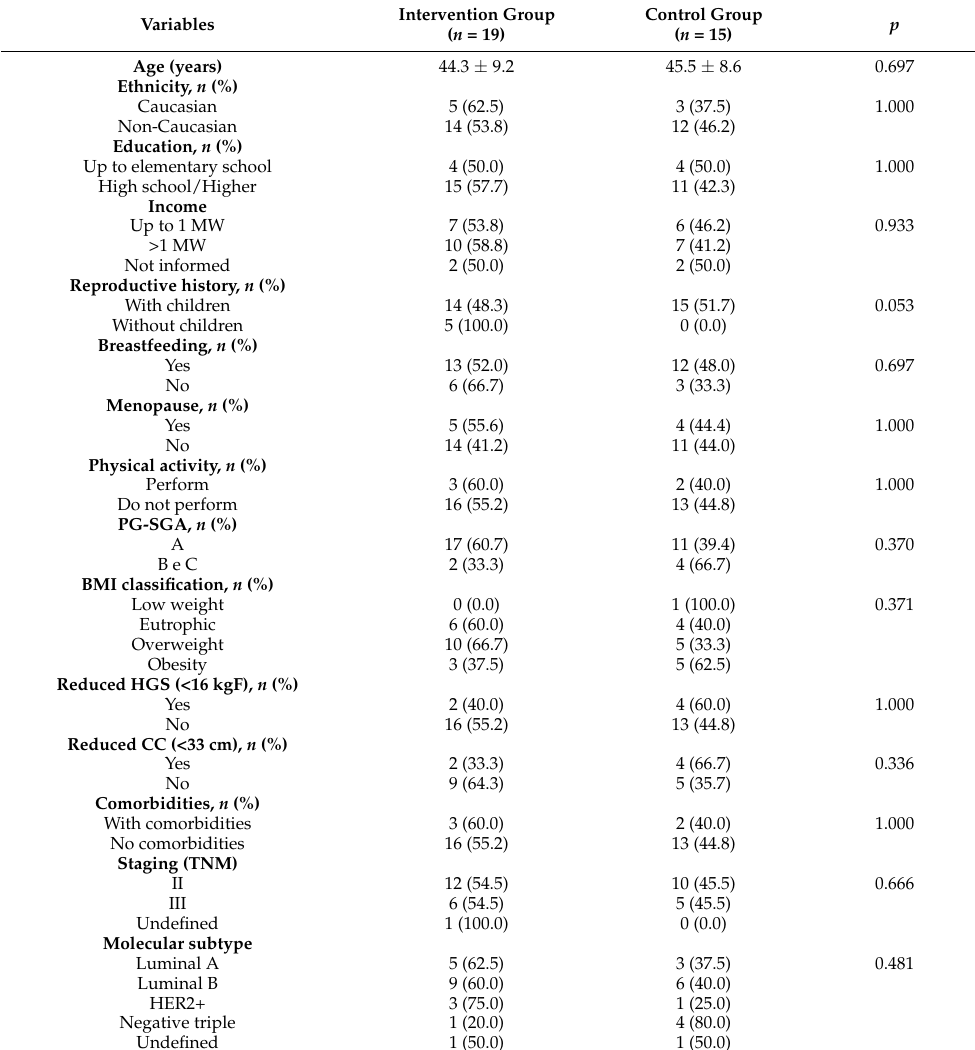
Table 1. Sociodemographic, nutritional and clinical characteristics of patients at the beginning of the study.